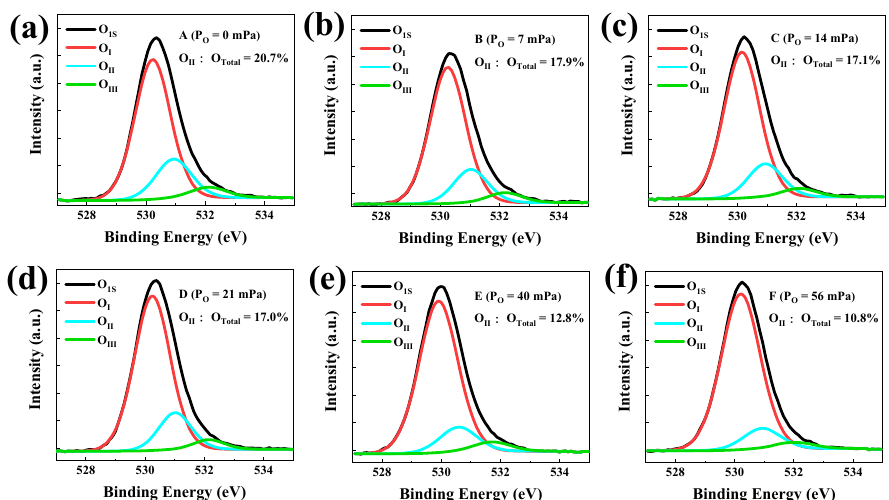
Figure 4. The XPS measurement and analysis results of the six a ‐ IGZO films. Here, samples A ( a ), B ( b ), C ( c ), D ( d ), E ( e ), and F ( f ) were deposited at the oxygen partial pressure of 0, 7, 14, 21, 40, and 56 mPa, respectively.